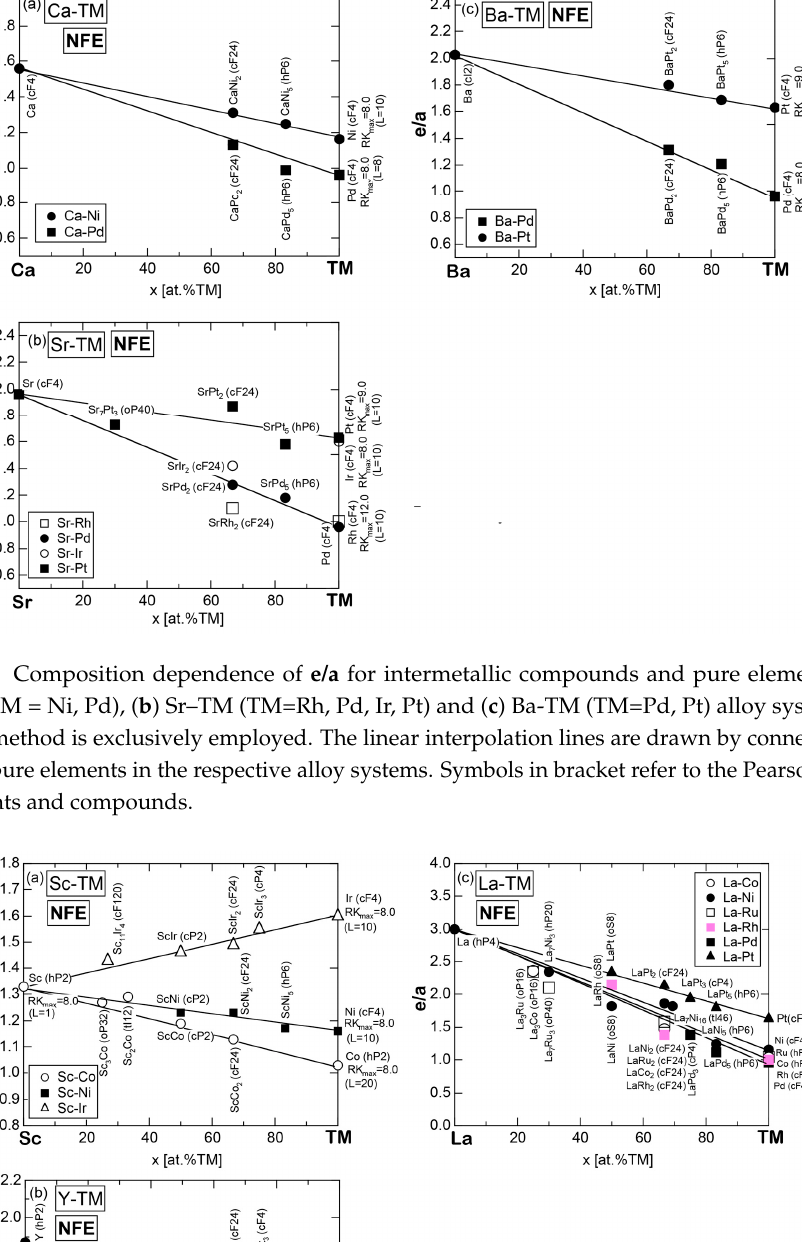
Figure 98. Composition dependence of e/a for intermetallic compounds and pure elements in ( a ) Sc–TM (TM = Co, Ni, Ir), ( b ) Y–TM (TM = Mn, Fe, Co, Pd, Re, Pt) and ( c ) La-TM (TM = Co, Ni, Ru, Rh, Pd, Pt) alloy systems [37]. The NFE method is exclusively employed. The linear interpolation lines are drawn by connecting end points of pure elements in the respective alloy systems. Symbols in bracket refer to the Pearson symbol for elements and